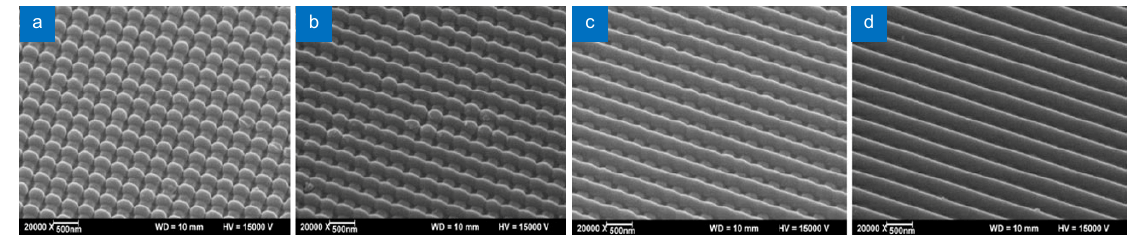
Fig. 15 | ( a ) SEM micrograph of the line-and-space pattern on fused silica observed at an inclined angle of 45°. ( b ) Confocal scanning laser microscopic picture of a grid pattern on fused silica. Figure reprinted with permission from ref. 85 , Springer-Verlag.